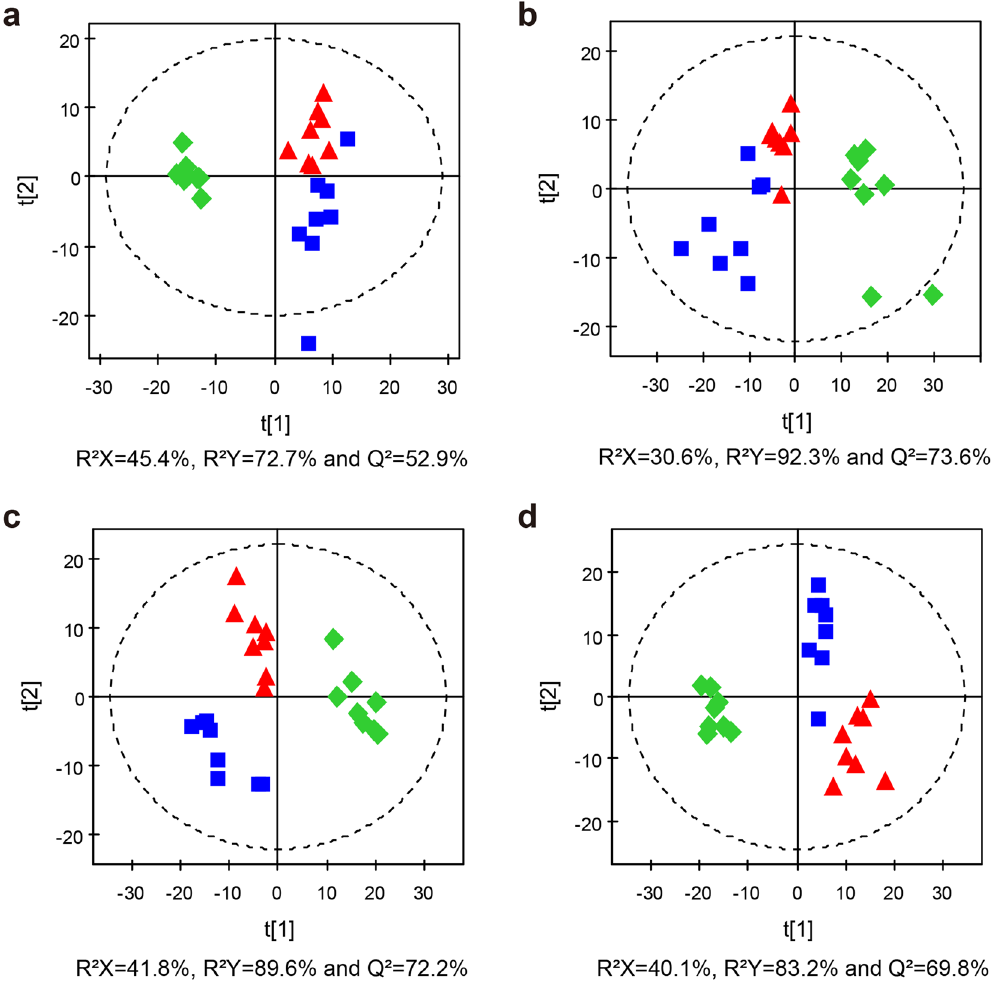
Figure 4. PLS-DA scores plots of the control ( ), SMFY ( ) and GMFS ( ) groups for ( a ) serum, ( b ) urine, ( c ) stomach extract, and ( d ) cortex